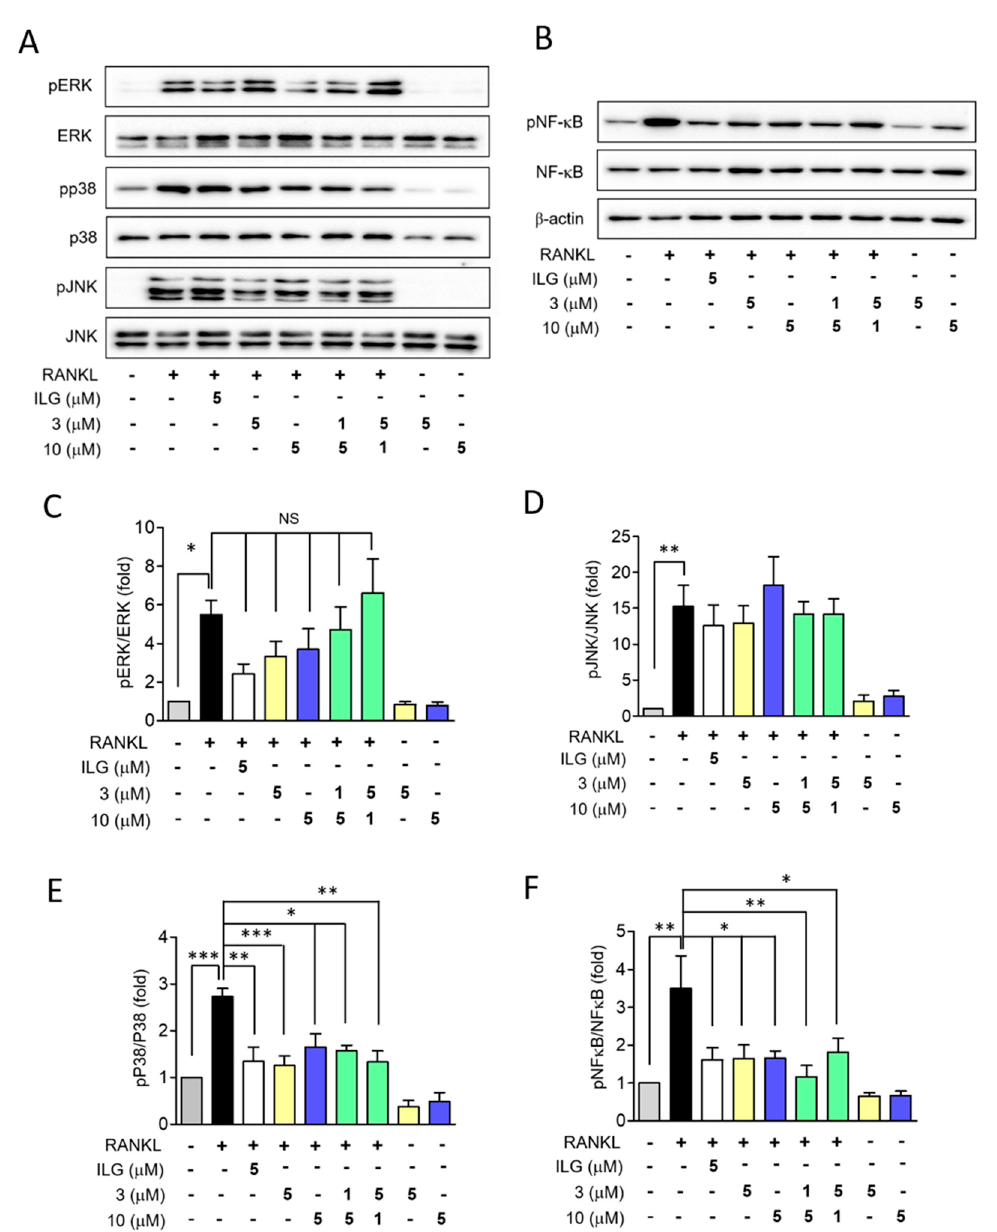
Figure 7. The inhibition e ff ect of phosphorylation of p38 and NF- κ B. RAW264.7 cells were pretreated with ILG, ILG derivatives, or ILG combination (3 + 10) for 1 h and stimulated with RANKL (40 ng / mL) for 10 min. The levels of osteoclast specific protein such as ( A ) ERK, JNK, and P38 and ( B ) NF- κ B were detected by Western blotting and phosphorylation levels were normalized to respective total levels in each case ( C – F ). Results are representative of at least three more independent data. * p < 0.05, ** p < 0.01, *** p < 0.001.